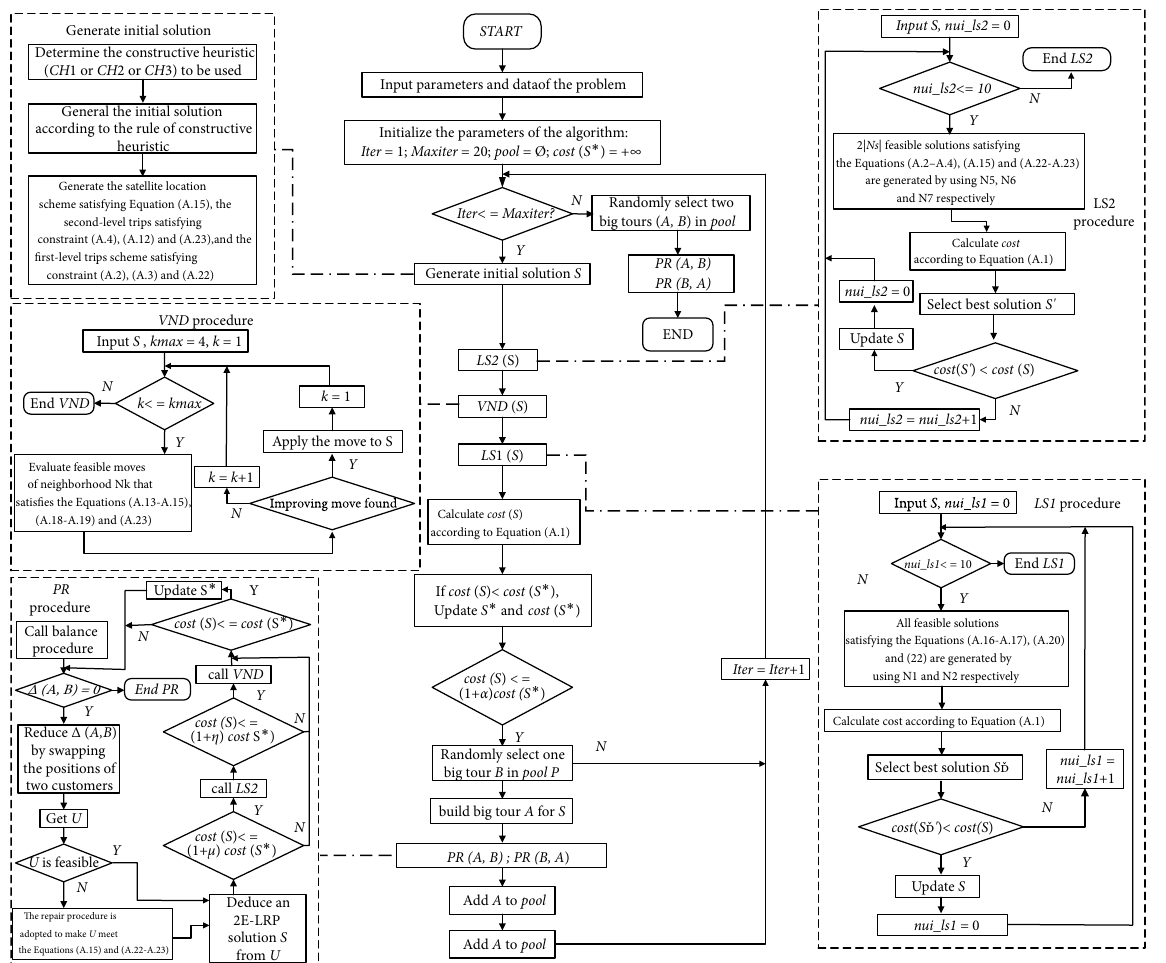
Figure 4: Flowchart of